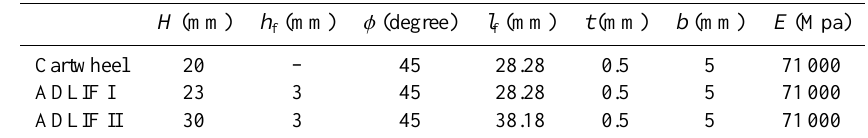
Fig. 4 Performance comparisons of a cartwheel hinge and two ADLIFs: (a) Stiffness; (b) Center-shift; (c) Stress.